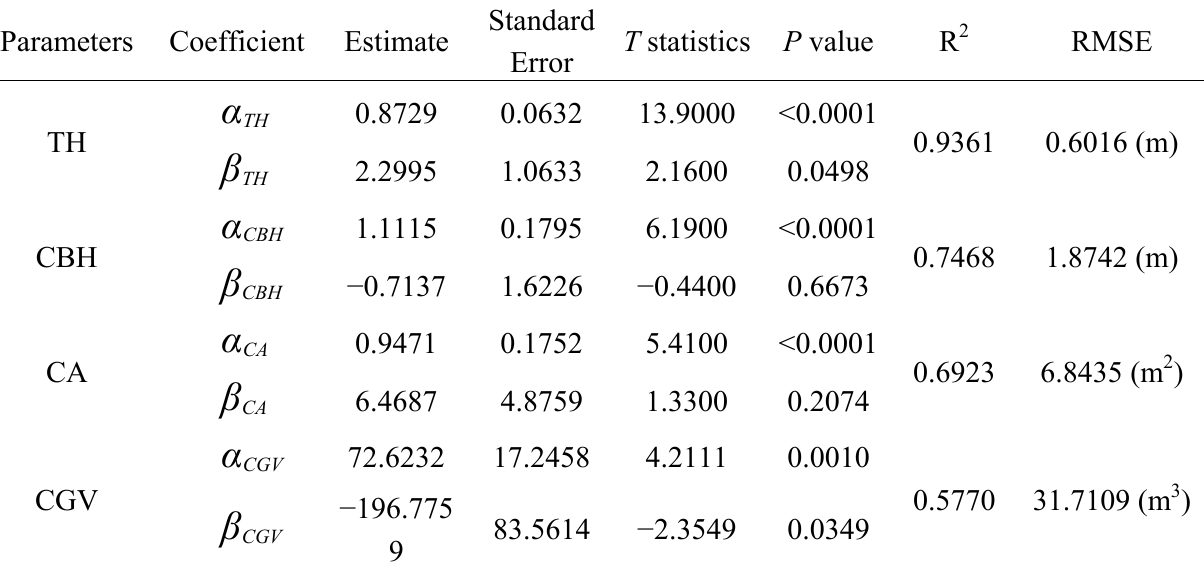
Table 2. Results of regression analysis on ALS- and TLS-derived TH, CBH, CA and